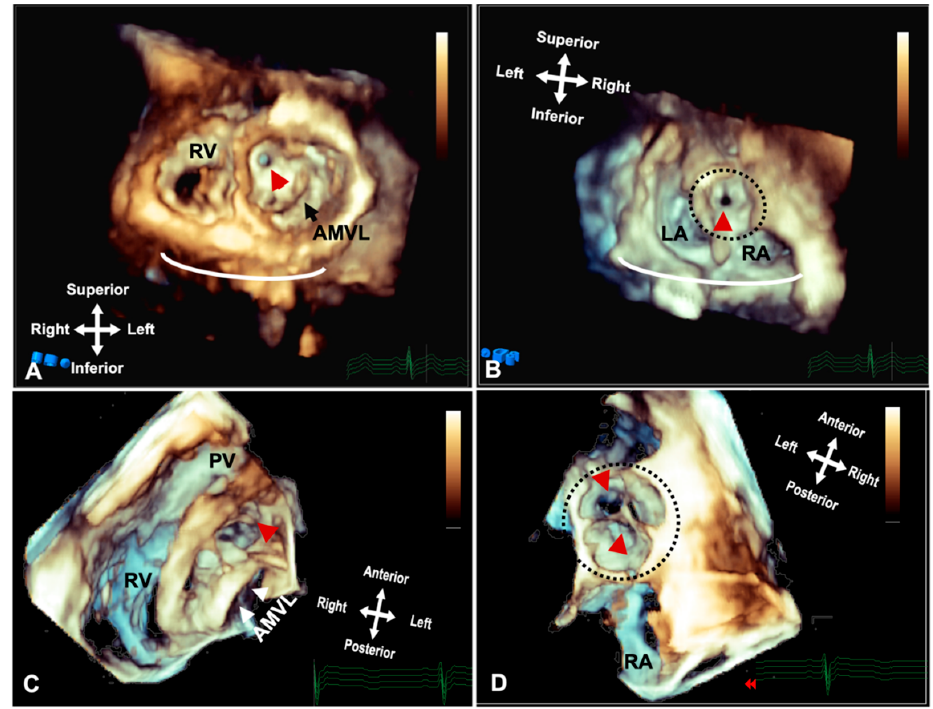
Figure 5. Three-dimensional rendered imaging from TTE/TOE demonstrating the appearance of significant subaortic stenosis. ( A ) TTE demonstrates a thickened circumferential ridge within the LVOT causing significant stenosis and leaving a small orifice (arrowhead) shown from the ventricular aspects and ( B ) the atria, with the aorta highlighted by a dashed line. ( C ) Shows a subaortic membrane as seen from the ventricular aspect and ( D ) from the atria with the circumferential membrane seen through the leaflets of the aortic valve highlighted by the dashed line. AMVL: Anterior mitral valve leaflet; LA: Left atrium; RA: Right atrium and RV: Right ventricle.